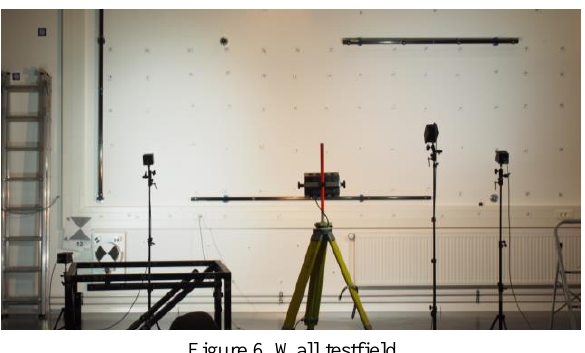
Figure 6. Wall testfield